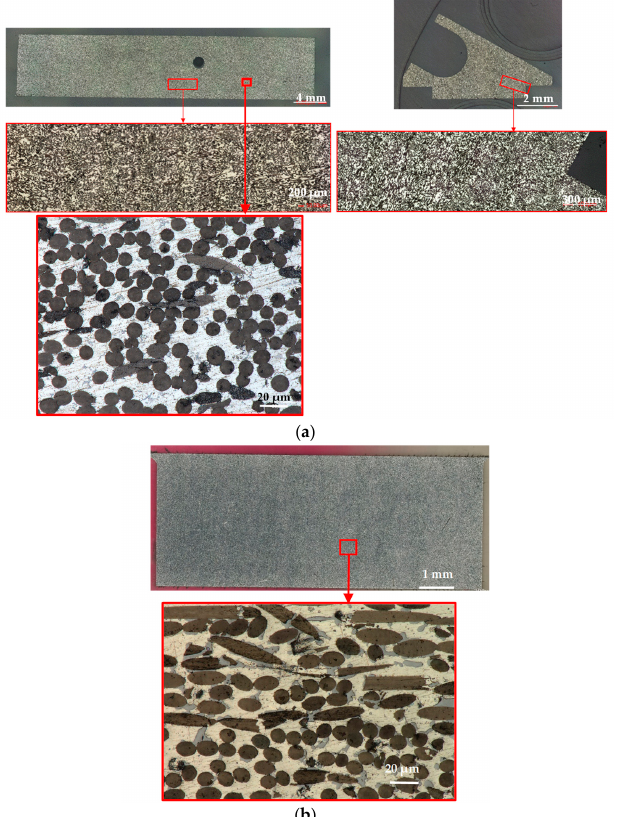
Figure 6. ( a ) Example of longitudinal (left) and transverse (right) metallographic cut of a PM adapter (reference sample, stored in laboratory conditions). The microstructure consists of randomly oriented C f (dark grey) in a matrix of Al (light grey) and eutectic AlSi (medium grey) phases; see also Figure 7. ( b ) Longitudinal metallographic cross-cut of a GPI adapter (as above). The microstructure consists of randomly oriented C f (dark grey) surrounded by the eutectic matrix featuring Al-rich (yellow) and Si-rich phases (light grey); see also Figure 10.